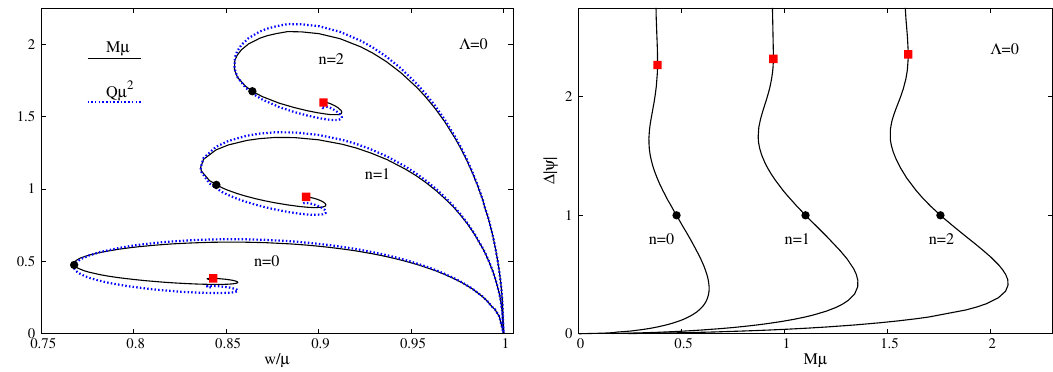
Figure 2 . Same as in (cid:12)gure 1 but for excited states ( n 6 = 0) without self-interactions ((cid:3) =